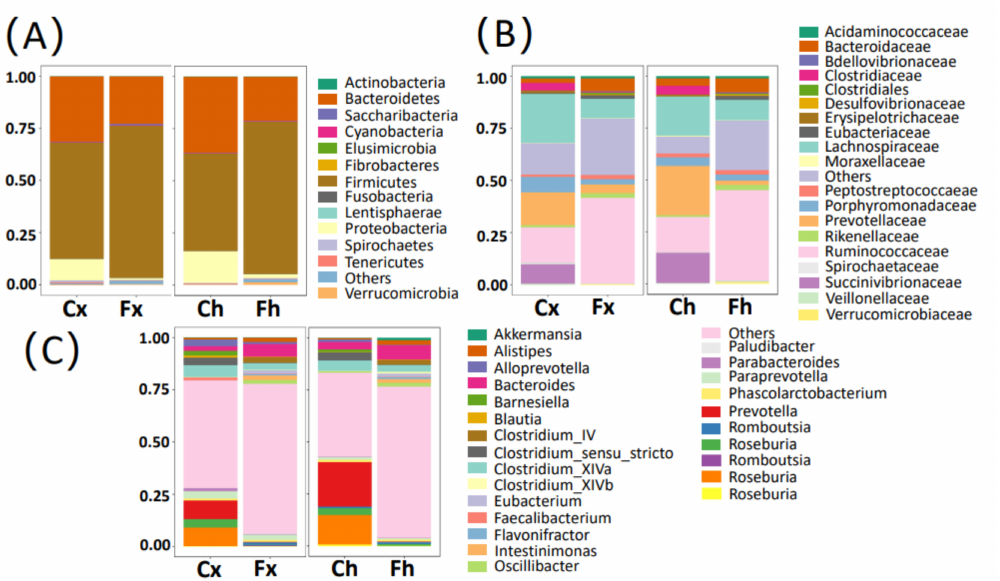
Figure 5. Intestinal microbiome composition of samples from different groups. The top 15 taxa with high abundance were selected to calculate the relative abundance to form a stack map: ( A ) composition of microbiota at the phylum level; ( B ) composition of microbiota at the family level; ( C ) composition of microbiota at the genus